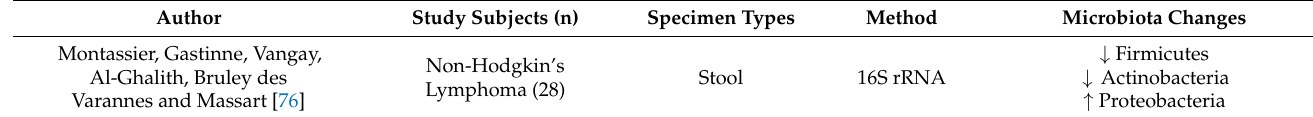
Table 1. Stool and Mucosal Dysbiosis following Chemotherapy in Humans.